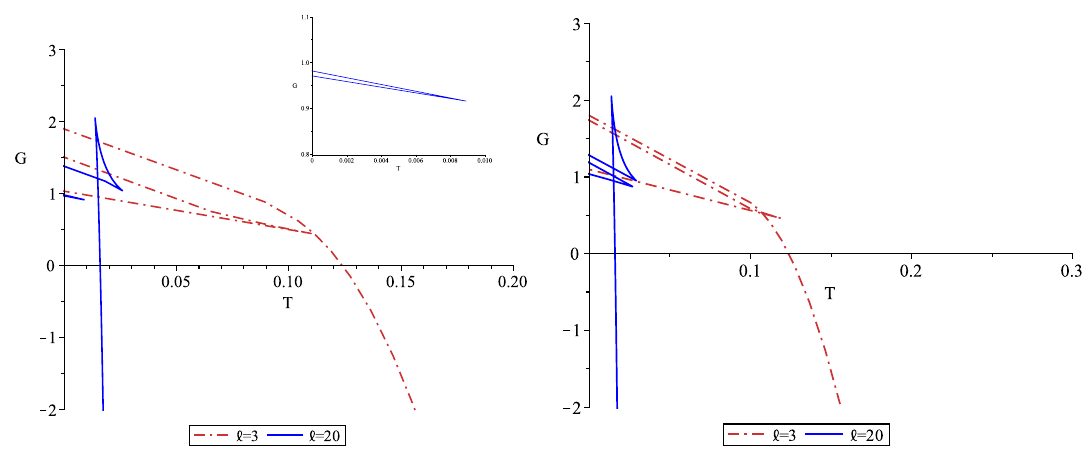
Figure 11 . Inverted Cusp. For P < P t we observe inverted cusp structures when there are three possible extremal black holes. Blue solid curves correspond to ‘ = 20 (low pressure) and red dot- dash curves to ‘ = 3 (high pressure). Left: we set n = 1 . 3 , Q e = − 1 . 39 , and Q m = 0 . 969 . The inverted cusps do not intersect the other curves corresponding to larger black holes. The inset provides a close up of the cusp for ‘ = 20 . Right: we set n = 1 . 3 , Q e = − 1 . 30 , and Q m = 1 . 10 . The inverted cusps intersect the other curves corresponding to larger black holes. These situations can occur in cases Ia and